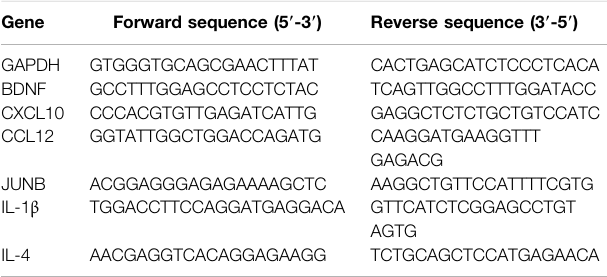
TABLE2| Theprimersequencesusedforreal-timequantitative polymerasechain reaction analyses. Gene Forward sequence (5 9 -3 9